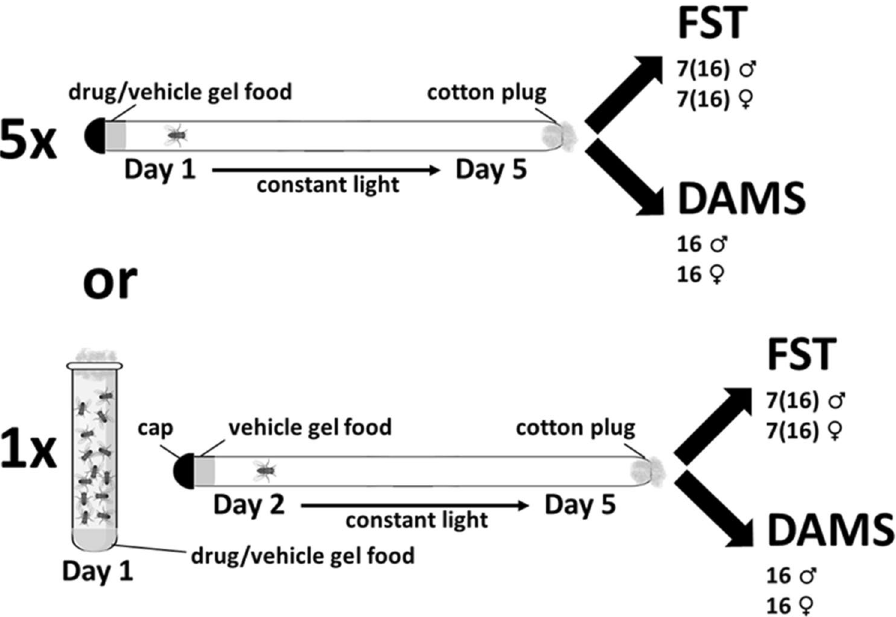
Figure 1. Experimental design for pulsed (1×) and chronic (5×) dosing. One-day old male and female flies were placed individually into transparent tubes plugged with a loose wad of cotton on one end, and with transparent food medium and a plastic cap on the other end. Food medium was either vehicle, METH (5.0 mM), αMT (3.0 mM), CIT (0.3, 1.0, or 2.5 mM), PSI (0.03 mM, 3.5 mM), KET (1.0 mM), or WAY (1.0 mM). 1× indicates that flies were fed for 24 h on treatment food under group conditions, then transferred into a tube containing vehicle medium (described above). 5× indicates that flies were fed for 5 consecutive days on treatment food in tube as described above. Flies were placed into the DAMS in groups of n = 16 for each sex in each treatment group, and kept at constant light conditions for at least 5 days while being monitored. All other flies were kept under constant light conditions for 5 days, then tested in the FST so that n = 7 for each sex in each treatment group, but the individual data points in the FST represent the mean behaviors of 16 flies. A total of 896 flies were used to generate n = 7 for males (448) and females (448) for each treatment group